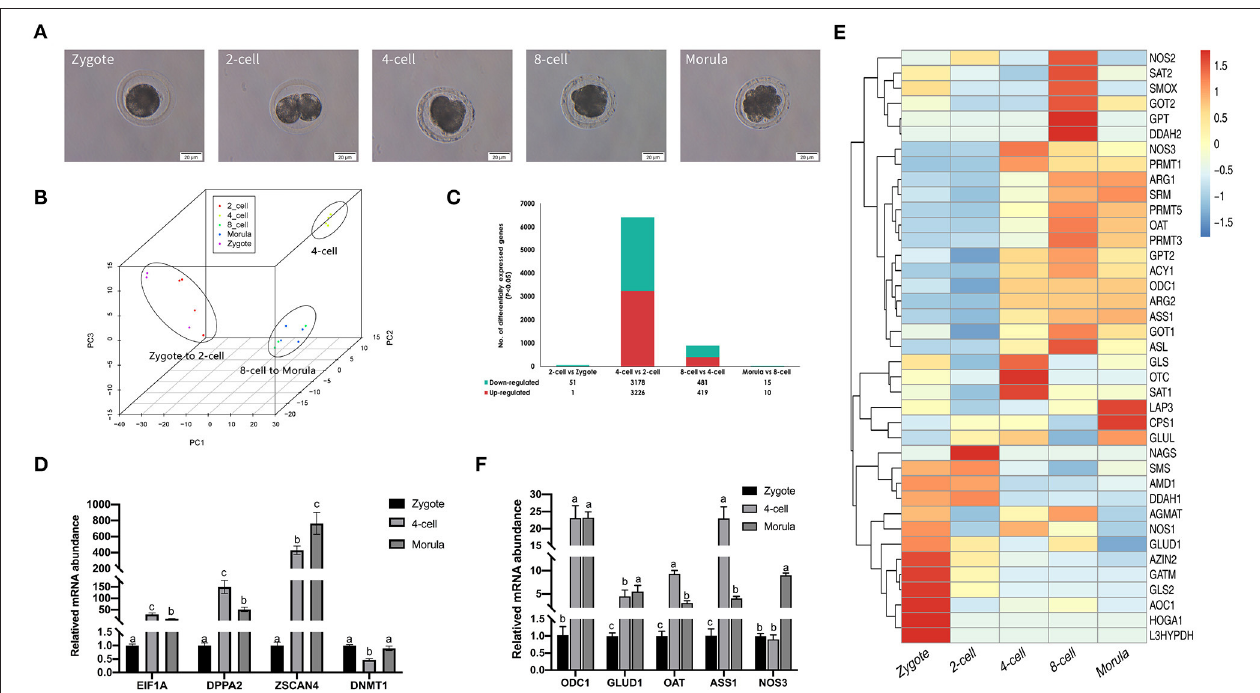
FIGURE 1 | Gene expression landscape of porcine pre-implantation development. (A) Microscopic imaging of porcine pre-implantation embryos in vivo (from left to right: zygote, 2-cell, 4-cell, 8-cell, and morula). (B) PCA of the transcriptome of single blastomeres from five stages of an in vivo porcine pre-implantation embryo. Dots of the same color represent blastomeres from different embryos at the same developmental stage. (C) Histogram showing upregulated and downregulated genes between two adjacent stages. (D) Results of qRT-PCR analysis of the expression of key zygotic genes. n = 3; different letters (a, b) indicate significant differences ( P = 0.05). (E) Results of qRT-PCR analysis of the expression of arginine metabolism-related genes. n = 3; different letters (a, b) indicate significant differences ( P = 0.05). (F) Arginine metabolism in porcine pre-implantation embryos. Arginine metabolism-related pathways from the KEGG database are shown in hierarchical clusters at five embryonic developmental